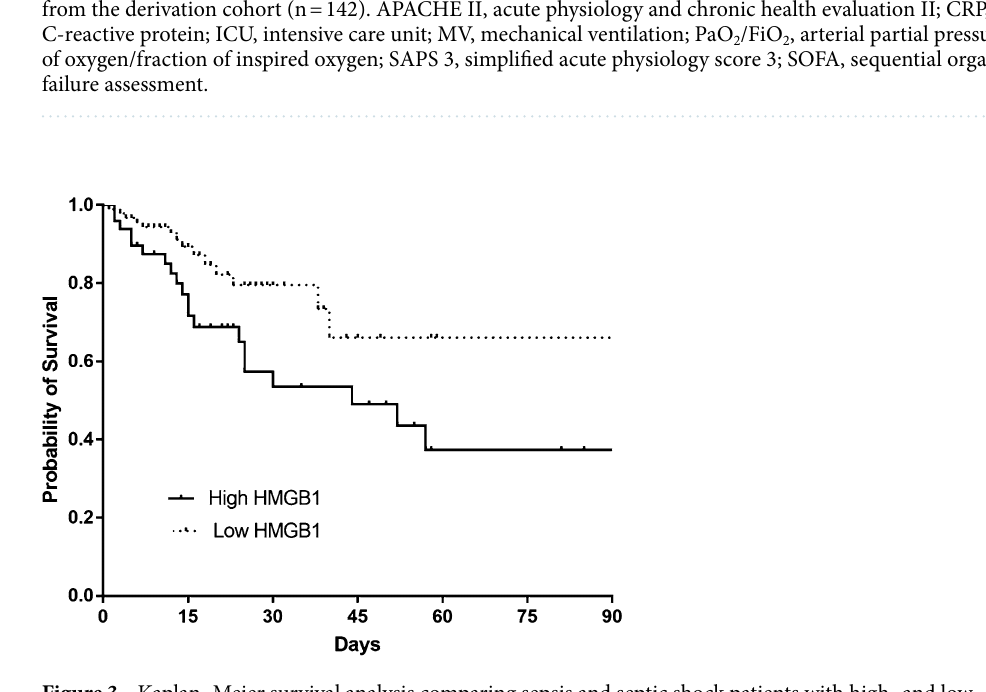
Figure 3. Kaplan–Meier survival analysis comparing sepsis and septic shock patients with high- and low- plasma levels of HMGB1 from the derivation cohort (n = 142) ( P = 0.009, log-rank